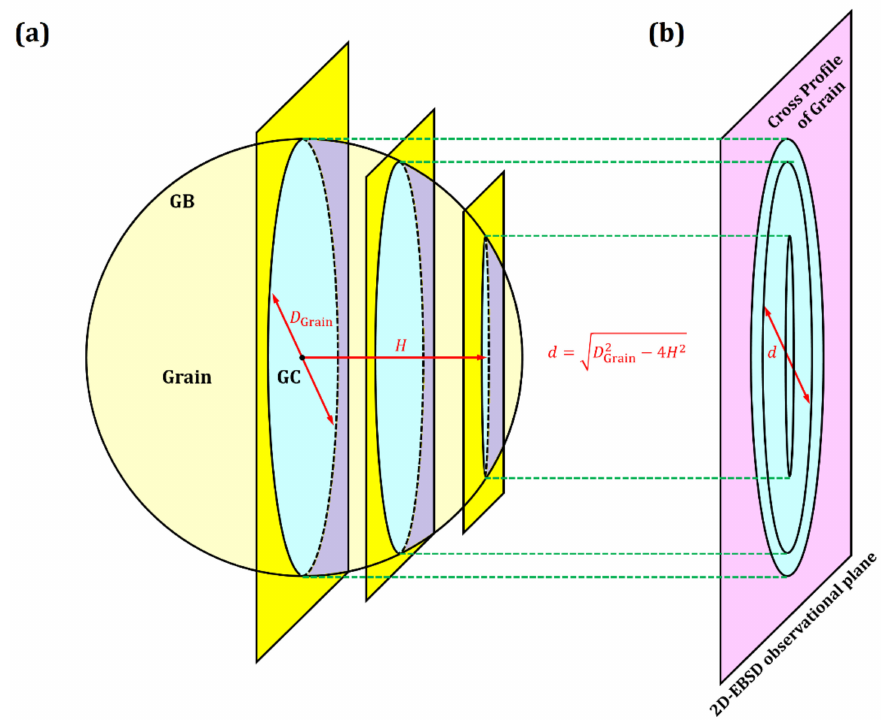
Figure 6. ( a ) The distance H between 2D-EBSD observational plane and GC, as well as ( b ) the cross profile sizes d shown on the 2D-EBSD observational plane.